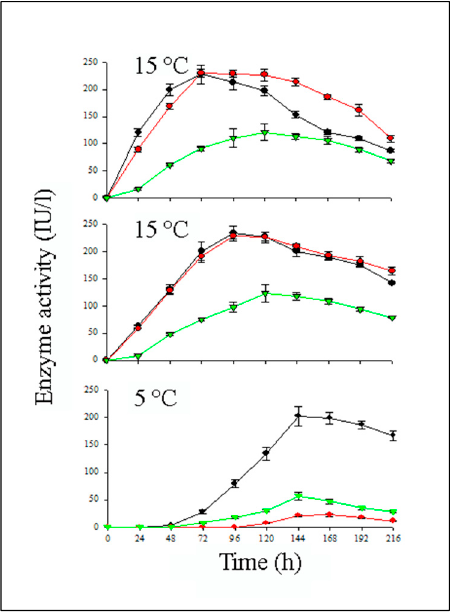
Figure 4. Chitinolytic activity of L. muscarium CCFEE 5003 ( black lines ), T. harzianum P1 ( green lines ) and T. harzianum T22 ( red lines ) at 5, 15 and 25 °C. (Modified from [43]).